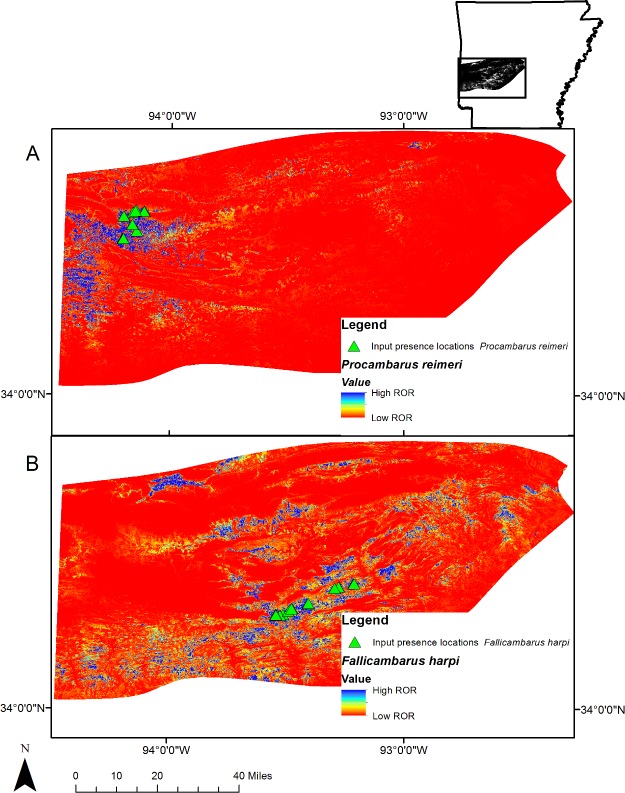
Projection of Maxent results.Projection of the Maxent models for (A) Procambarus reimeri and (B) Fallicambarus harpi onto the environmental variables (Table 1) used for analysis in western Arkansas. The total shaded area represents the Ouachita Mountains Ecoregion (OME). Cooler colors show areas with better predicted conditions (relative occurrence rates [ROR]).